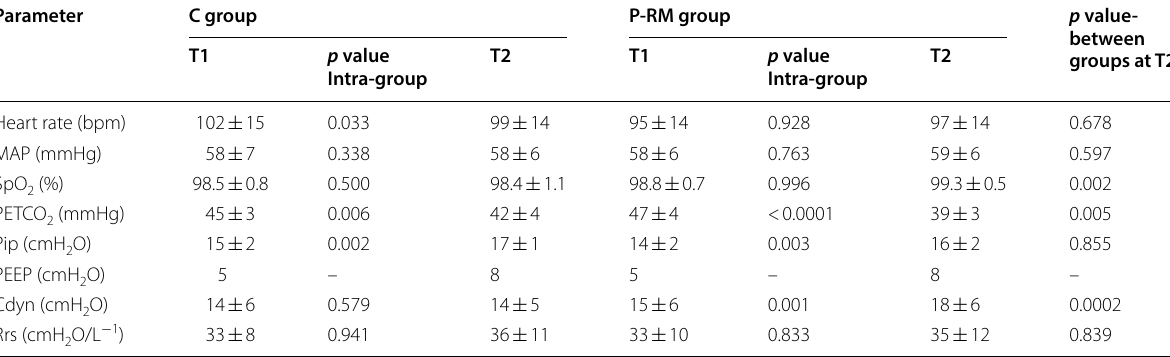
Table 2 Hemodynamics and respiratory